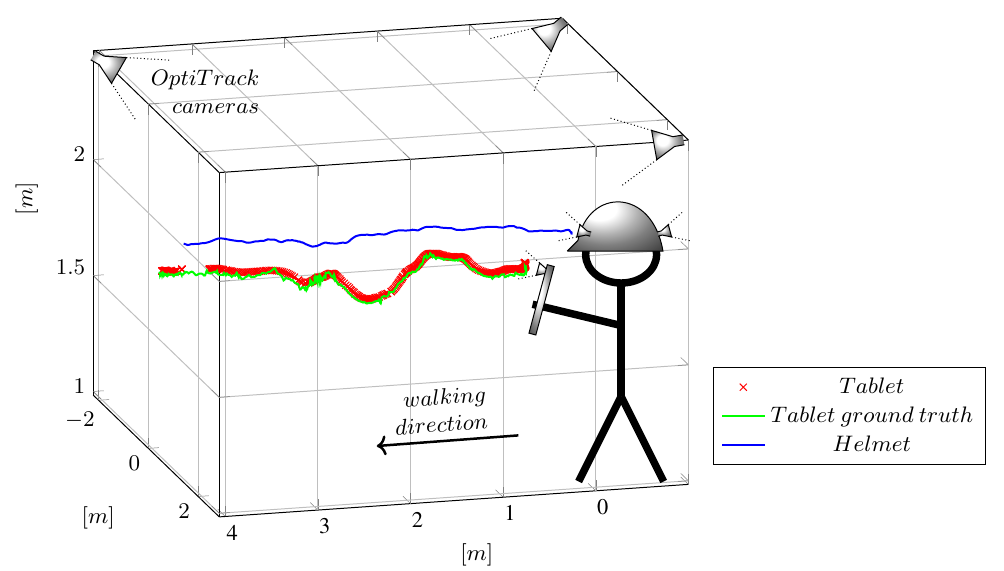
Figure 6. Evaluation trajectory: the trajectory of the helmet (blue) and the ground truth trajectory of the tablet (green) have been directly tracked by OptiTrack, while the tablet trajectory (red) has been derived from the helmet pose via the respective relative tracking